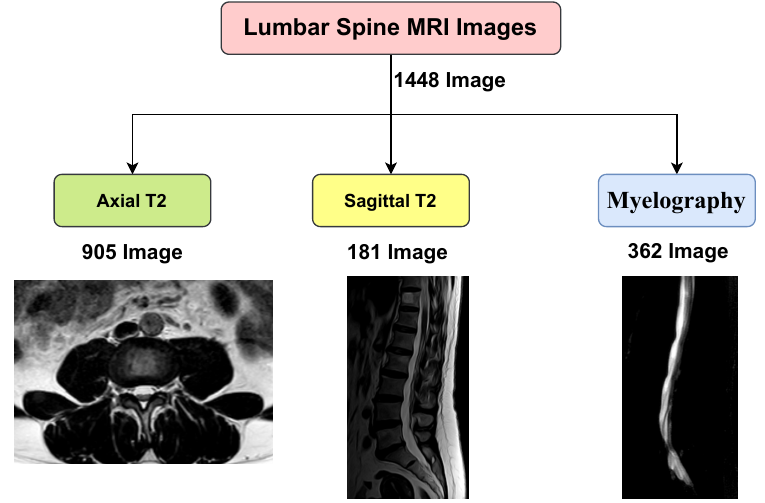
Figure 3. Number of MRI images in our dataset.